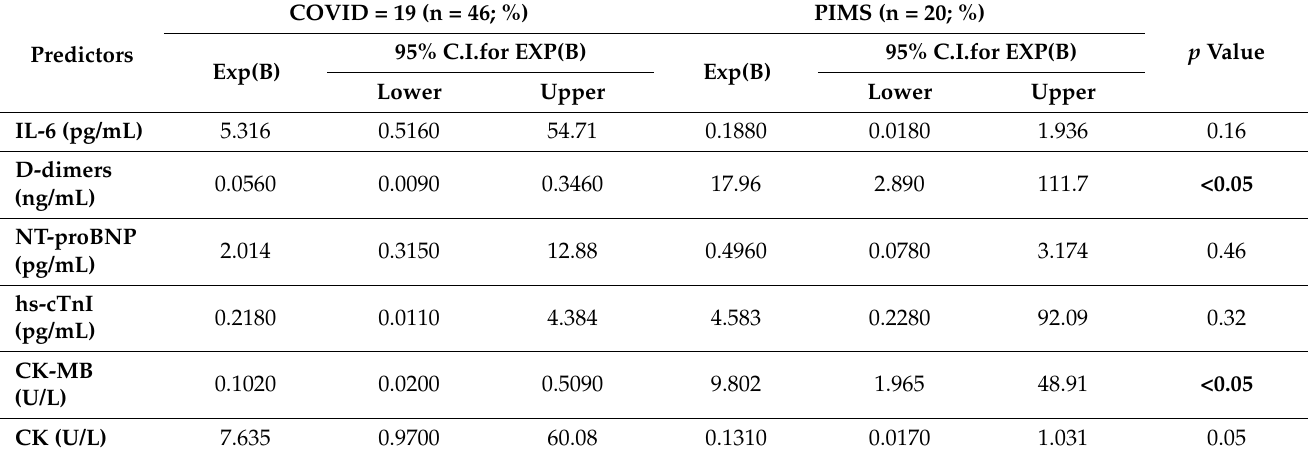
Table 5. The logistic regression of predictors in COVID-19 versus PIMS groups.